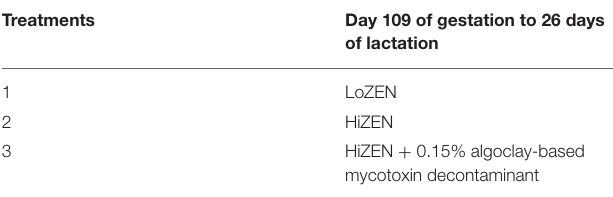
TABLE 1 | Experimental treatments.